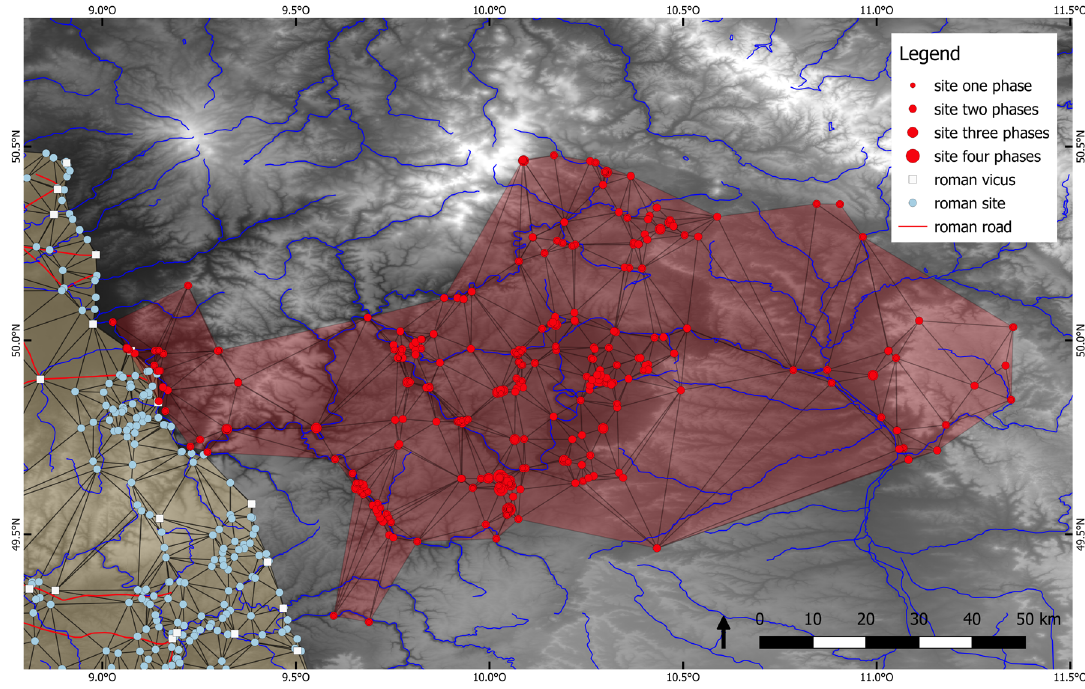
Figure 9. Sites dating to the Late Roman Iron Age (Eggers Phase C, 180-380 AD)−the settlement cluster at the time of its largest expansion with a large contact zone to the Roman Empire. Through the construction of the new eastern fortification line of the roman Odenwald Limes after 159/161 and 165 AD, the roman world comes closer to the Barbarian settlement cluster at river Main. Many sites in the inner settlement cluster date to three or four periods of the Roman Iron Age and the Early Migration Period. These were often in continuous use as settlements or cemeteries since the Early Roman Iron Age. Sources: see Fig. 3, GIS